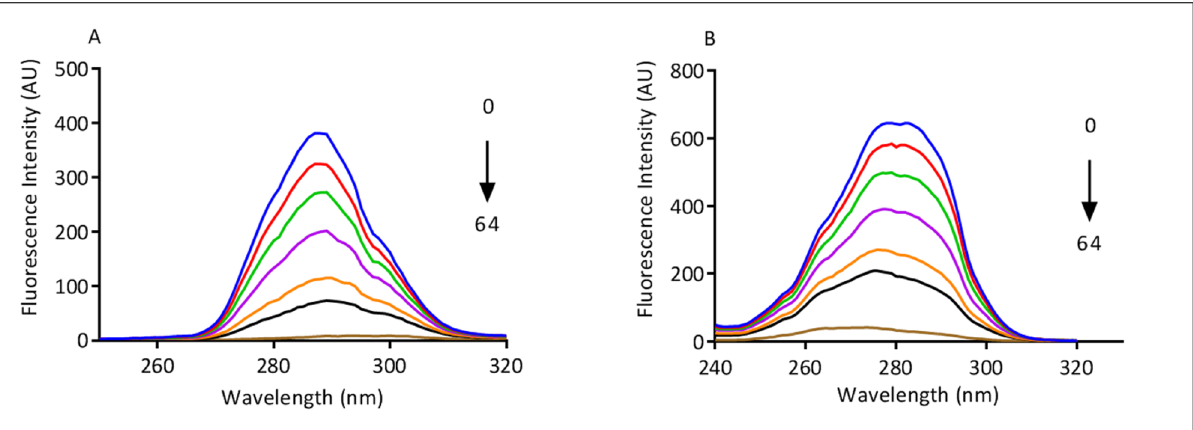
Figure 4. ( A ) Synchronous emission spectra of BSA (5 µM) with MiADMSA (0–64 µM) at Δλ = 15 nm for Tyr ( B ) Synchronous emission spectra of BSA (5 µM) with MiADMSA (0–64 µM) at Δλ = 60 nm for Trp at 298